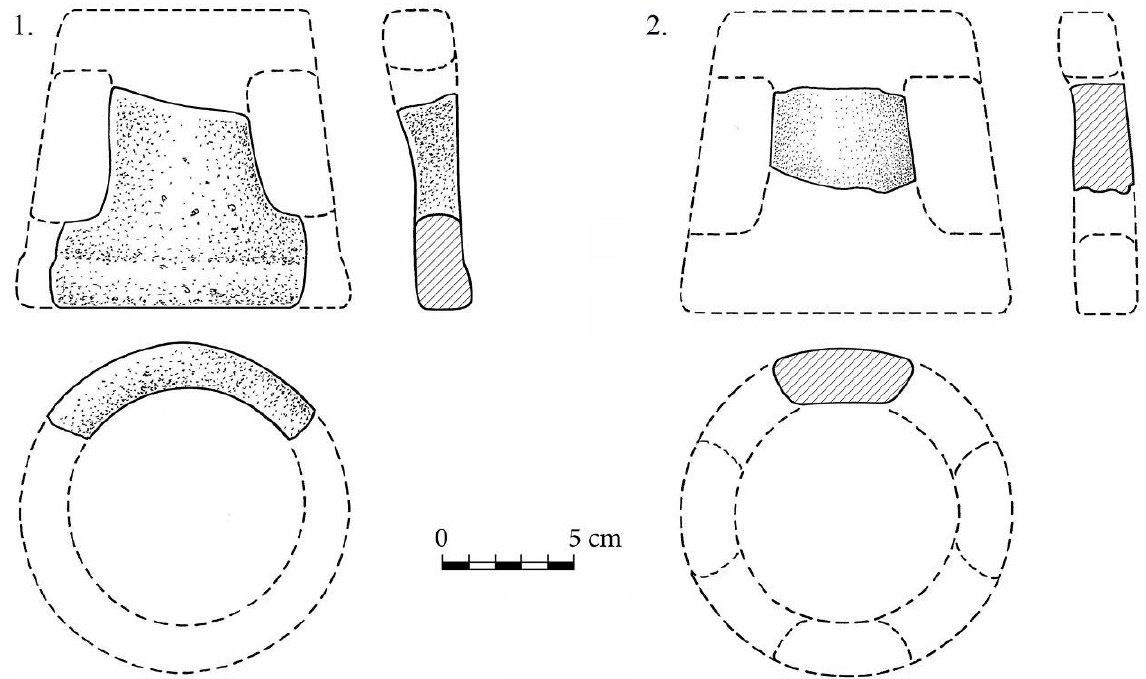
Figure 4. Fenestrated type. 1. Basket C75, locus - C42, raw material - basalt, notes - base and ‘window’ fragment. 2. Basket B81/3, locus - B9, raw material - basalt, notes - small ‘window’